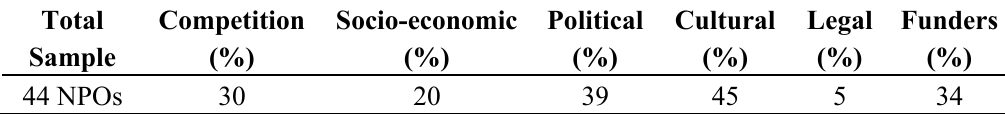
Table 7. NPOs’ perception of their influence on external dimensions.